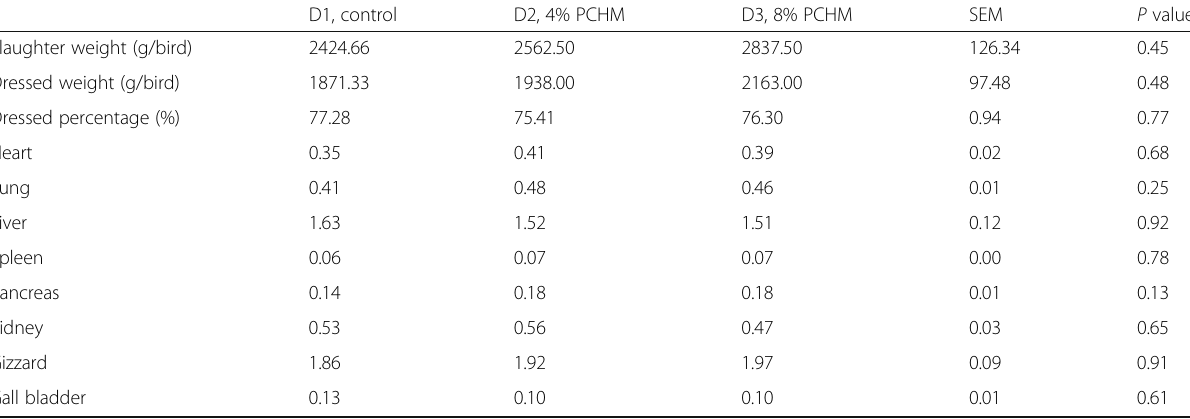
Table 5 Effects of processed cocoa pod husk meal (PCHM) on carcass traits and relative internal organs (%